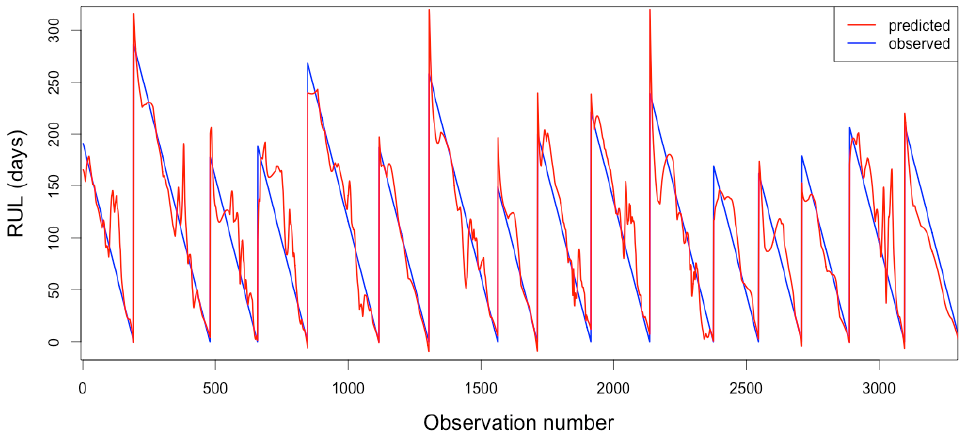
Figure 8. Comparison between the remaining useful life observed and predicted by the hybrid ABC–MARS ‐ based model for aircraft engines ( r = 0.92) for the first 3200